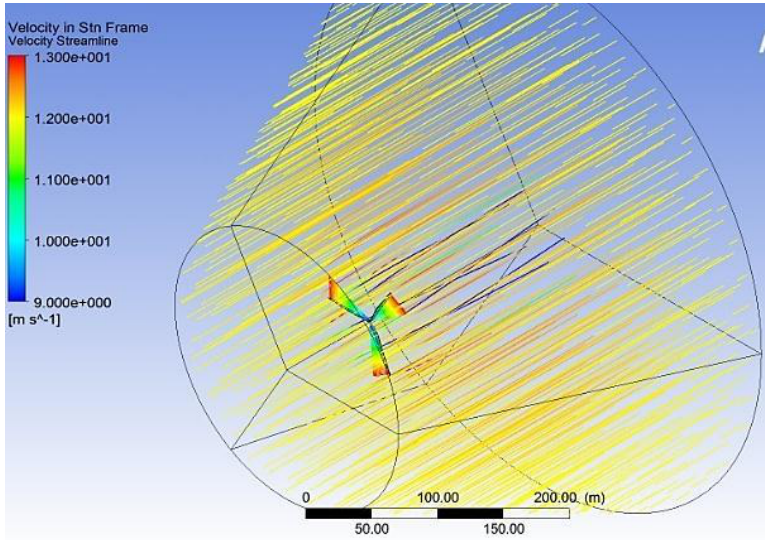
Figure 14. Blade velocity streamlines . Note that the legend bar in the above picture presents color graduation from blue, which is the lowest velocity, until red. The inlet section has a yellow color so it is 12 m/s,